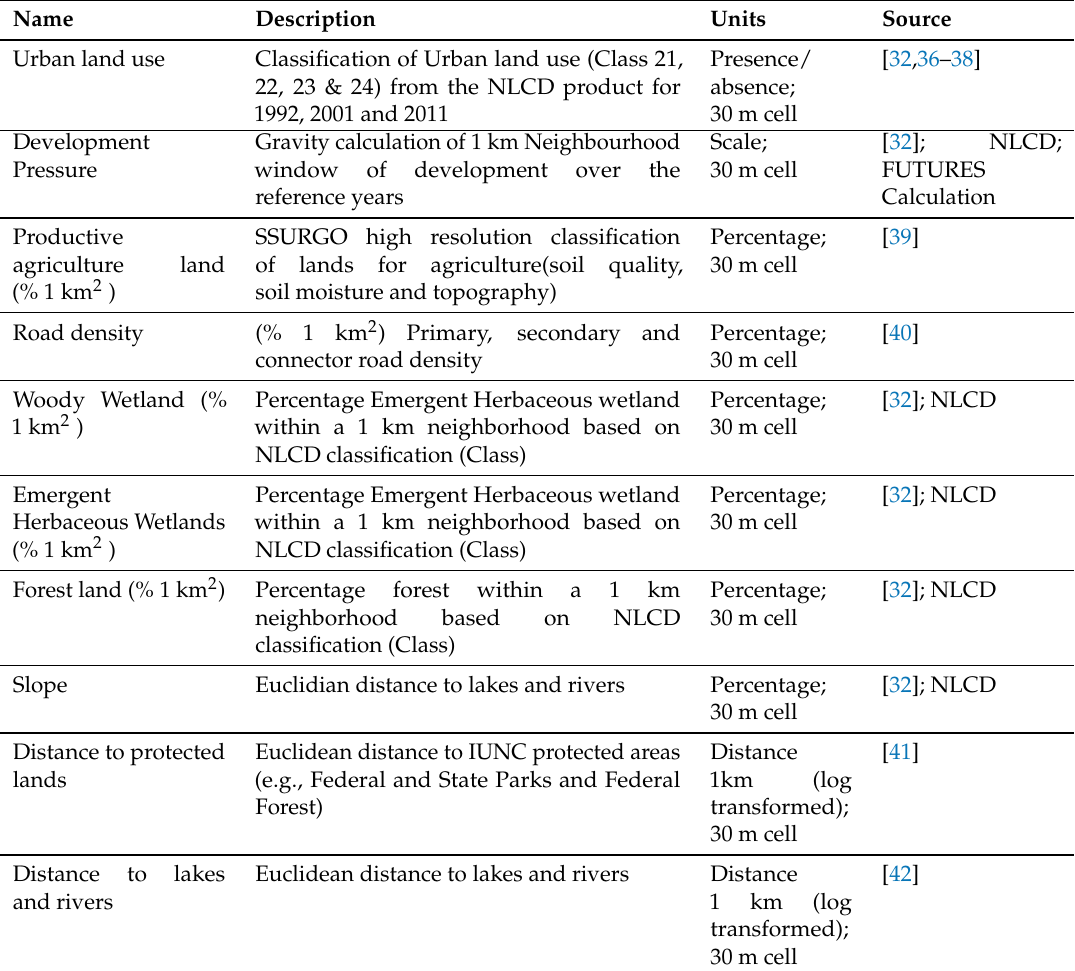
Table 1. Description of independent variables included in estimated model of urban development